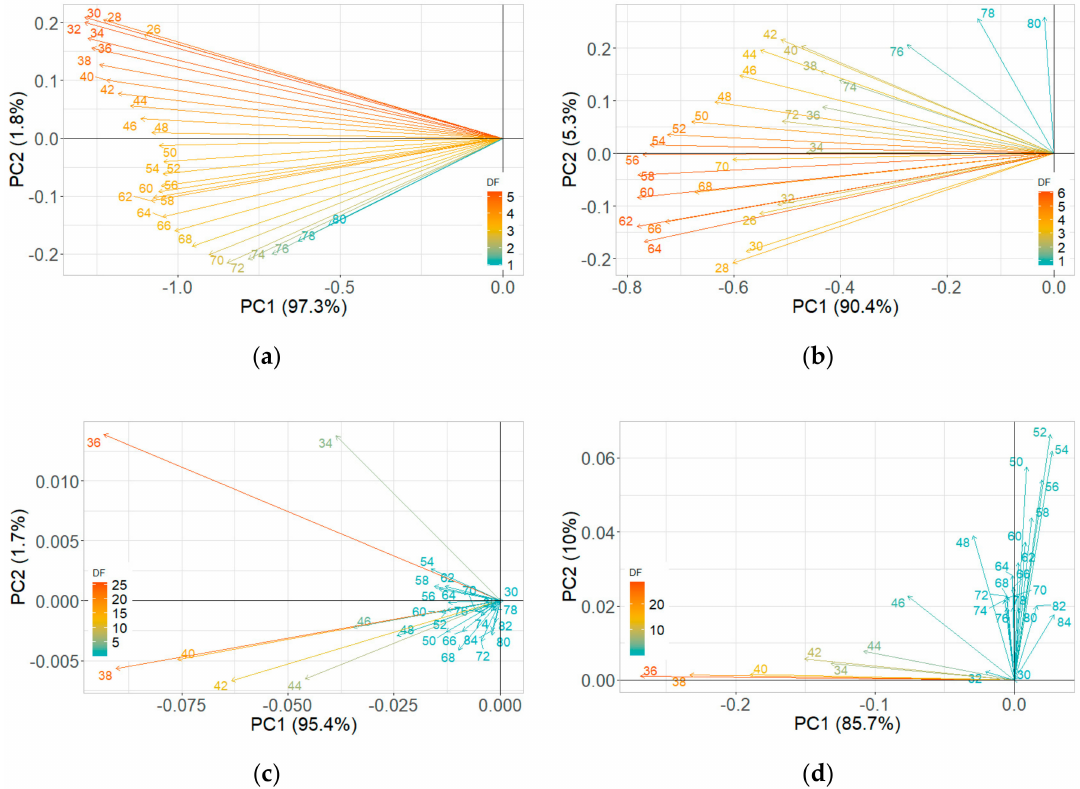
Figure 8. Principal component analysis loading plots for ion current of Ranger Russet tuber samples stored at room temperature (25 ◦ C, experiment-1) on ( a ) 0th and ( b ) 14th days after inoculation, and Russet Burbank tuber samples stored at room temperature (25 ◦ C, experiment-2) on ( c ) 0th and ( d ) 14th days after